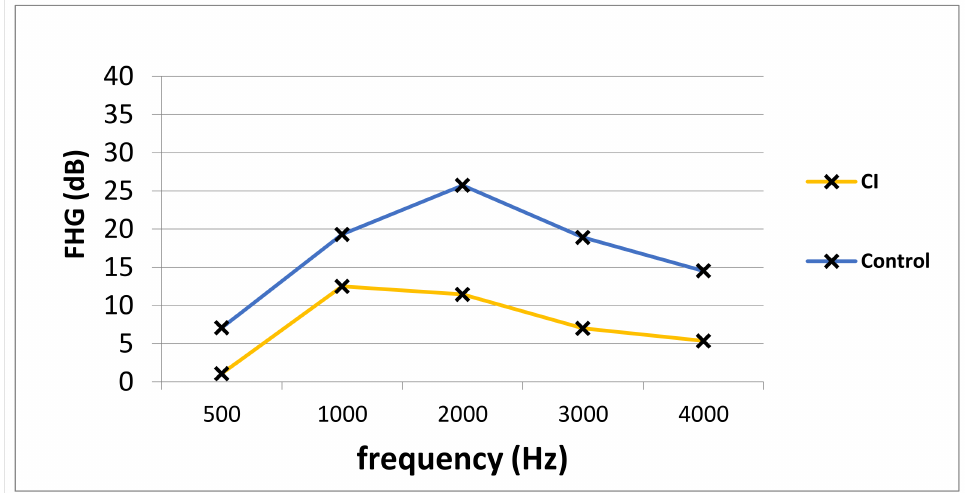
Figure 1. The PTA FHG in the CI and the control group. PTA, pure-tone audiometry; FHG, functional hearing gain; Hz, Hertz; dB, Decibel; CI, cochlear implant group; Control, control